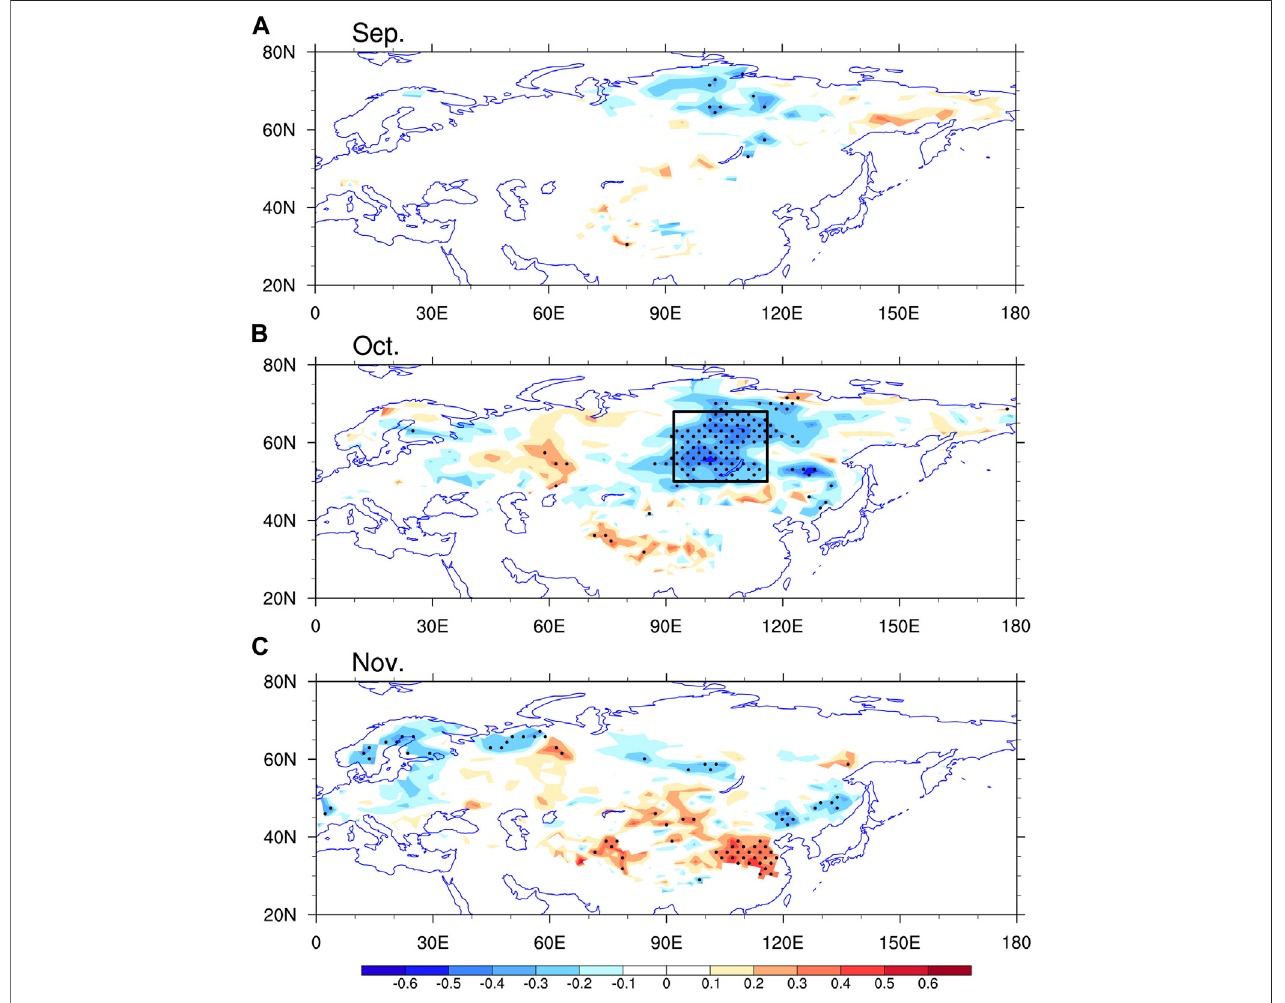
FIGURE 1 | Correlation coef fi cients of snow cover in (A) September, (B) October and (C) November with SC_SEPI during 1979 – 2017. Stippled regions indicate that the anomalies are signi fi cant at the 90% con fi dence level. The box in (B) indicates the region used to de fi ne the SNOWI.